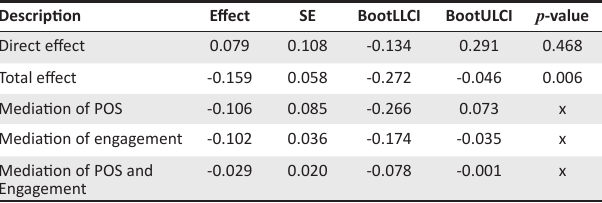
TABLE 9: Effect of human resource practice on turnover